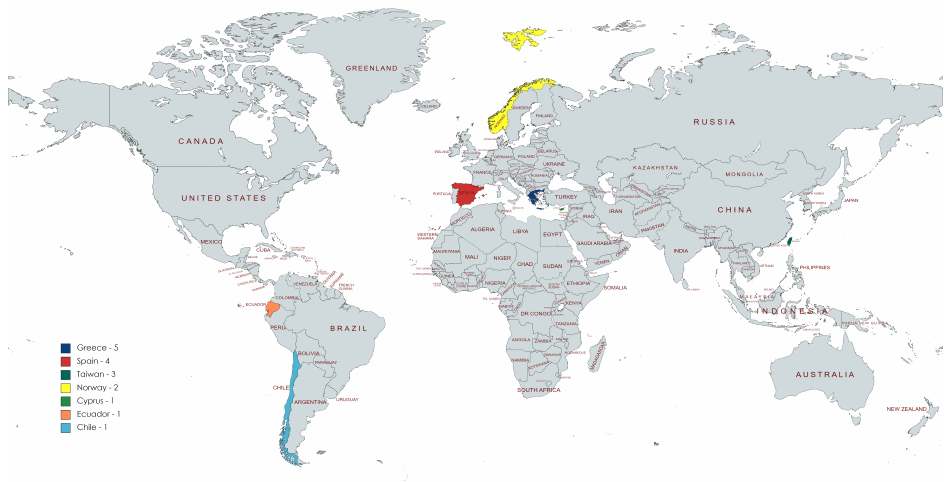
Figure 1. Geographical distribution of academic institutions participating in the Special